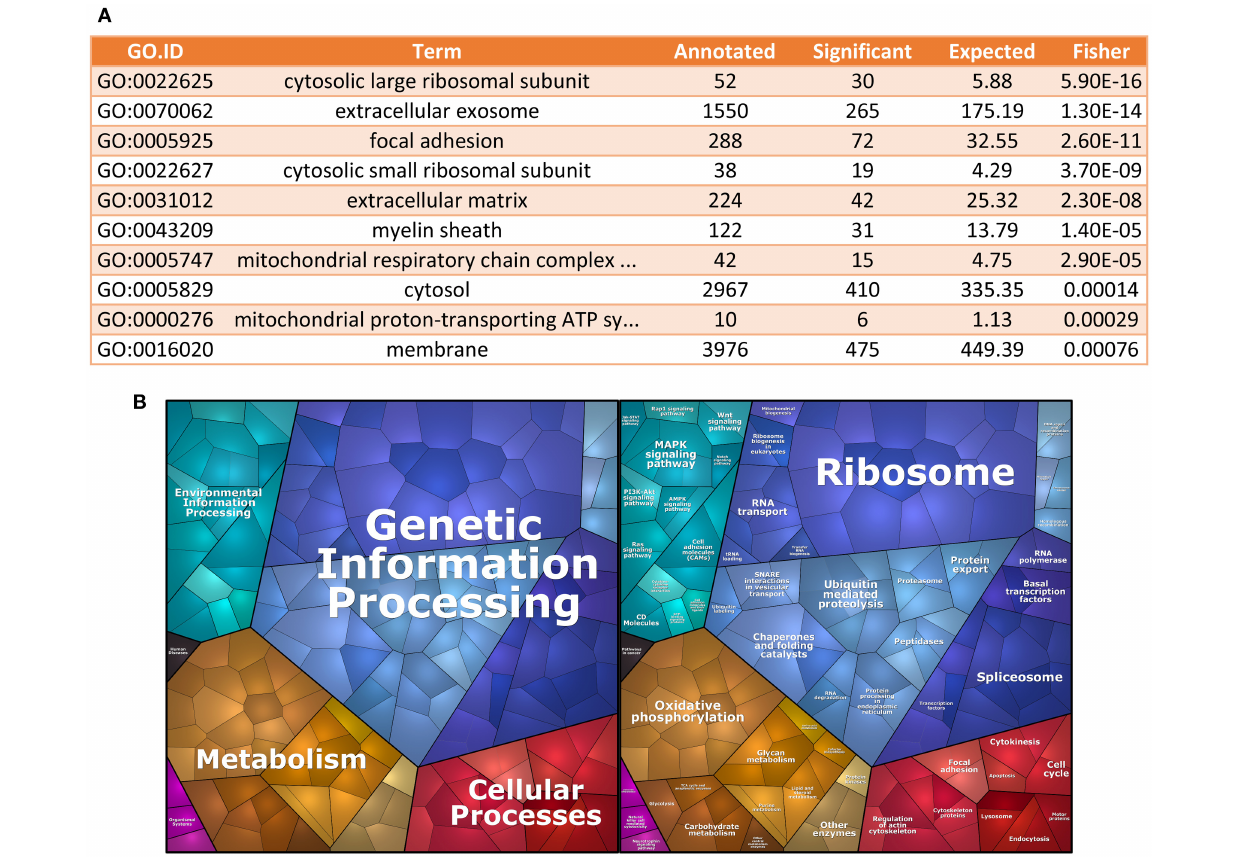
FIGURE 2 | Gene Ontology analysis for most stable genes. (A) GO enrichment analysis. The table shows the top 10 GO terms for the Cellular Component domain, using the top 1,000 most stable genes in the dataset. Ribosomal proteins seem to be the most enriched component within the most stable genes. (B) Proteomap of the most stable genes. The terms shown in the Voroni plot are based on the KEGG Pathways gene classification. Each gene is shown by a polygon and functionally related proteins are arranged in common